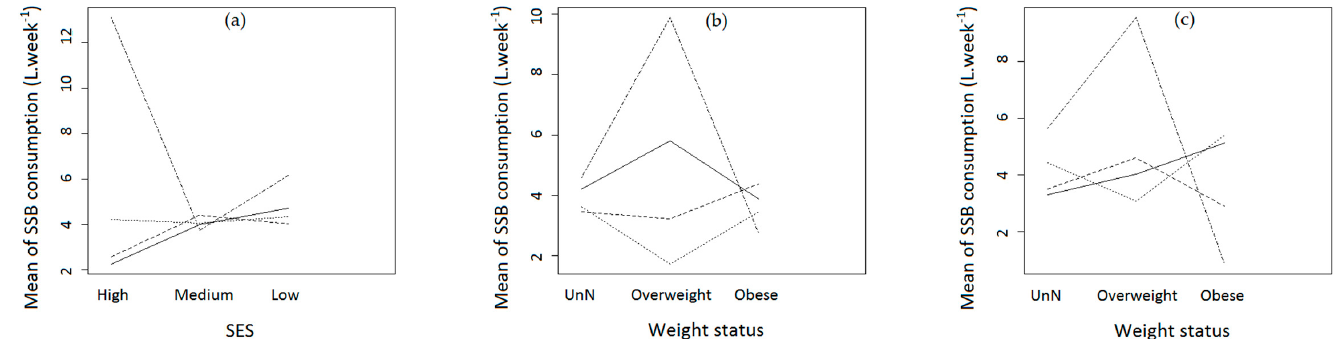
Figure 1. Pairwise factor interaction plots for SSB consumption: ( a ) Socioeconomic status (SES) vs. knowledge about energy expenditure, p = 0.005; ( b ) Weight status vs. knowledge about sugar, p = 0.011; ( c ) Weight status vs. knowledge about energy expenditure, p = 0.002. Type of line corresponds to knowledge. Solid line: adolescents who overestimated; dashed line: adolescents who gave accurate answers; dotted line: adolescents who underestimated; dotted-dashed line: adolescents who did not know.